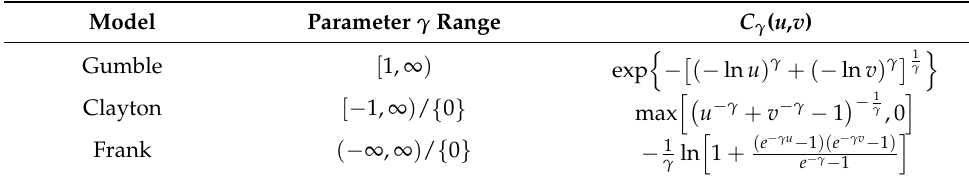
Table 1. The three most common binary copula functions.